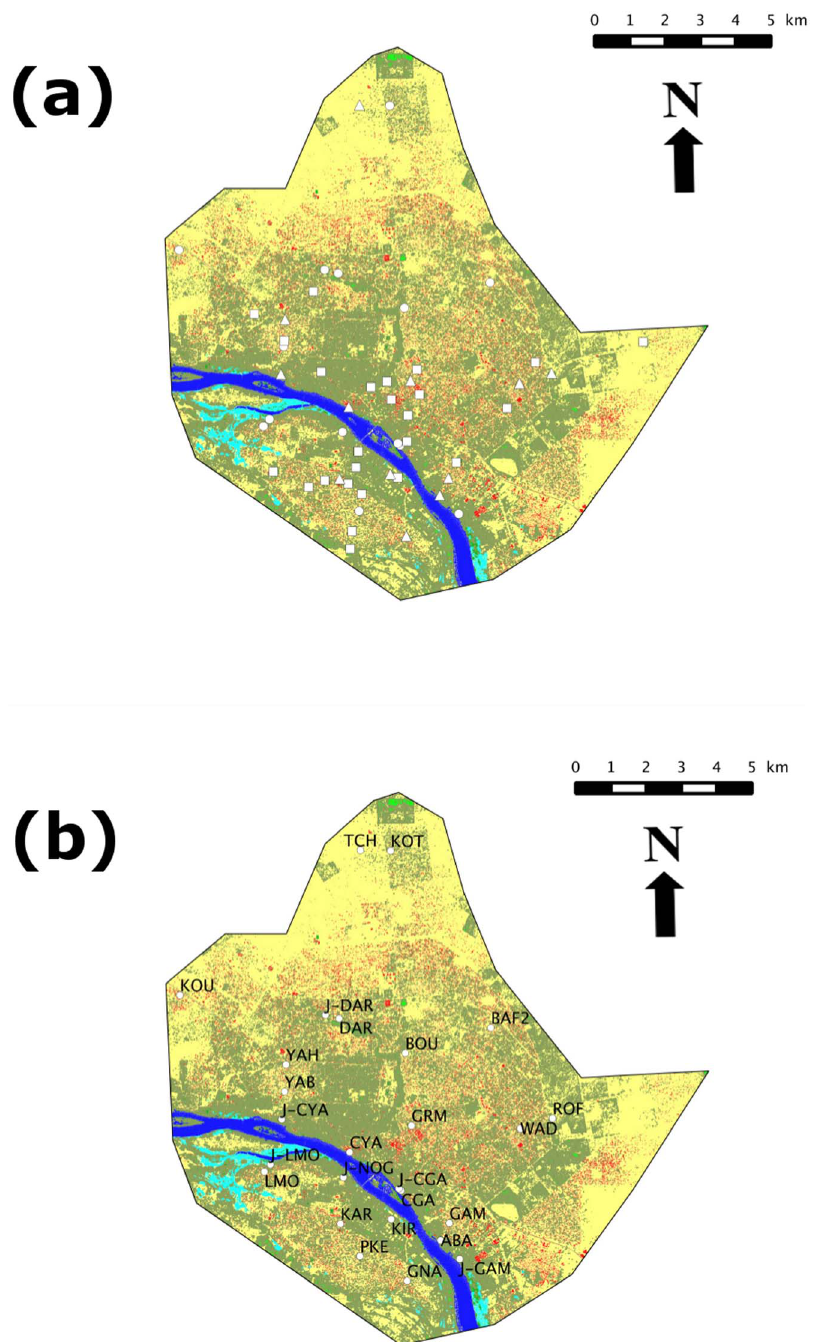
Figure 1. All trapping investigated localities within the city of Niamey (a): circles, squares and triangles indicate sites investigated through SP, OP and SP + OP protocols, respectively. Mapping of SP localities only, with their acronyms referring to Table 1 (b). On both maps, colors of the background correspond to GIS-based categories of landscape elements: yellow for non-covered soil; red for buildings; dark and light green for trees and diverse vegetation, respectively; dark and light blue for Niger River and other water surfaces, respectively.